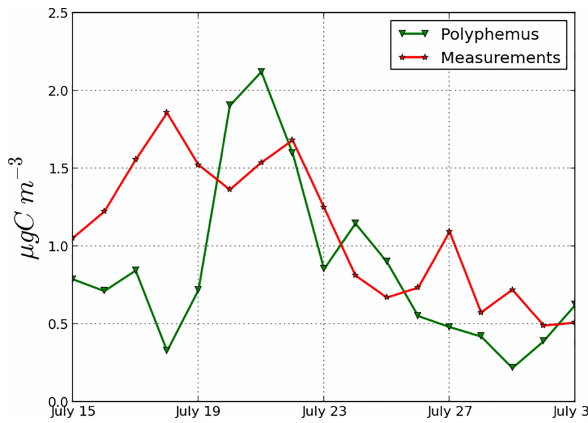
Figure 7. Measured and simulated submicron water soluble organic carbon (µgCm − 3 ) at